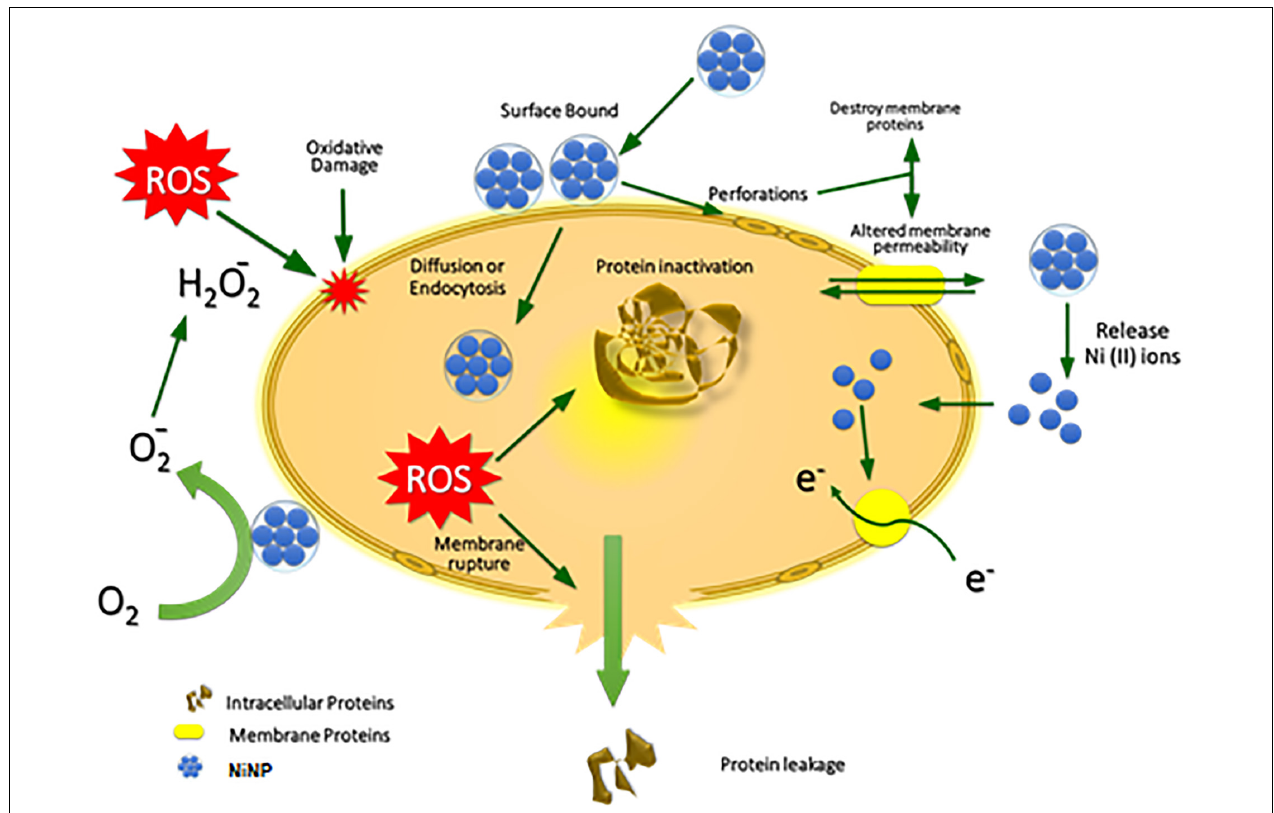
FIGURE 7 | Hypothetical mechanism of antibacterial activity of NiO nanoparticles.